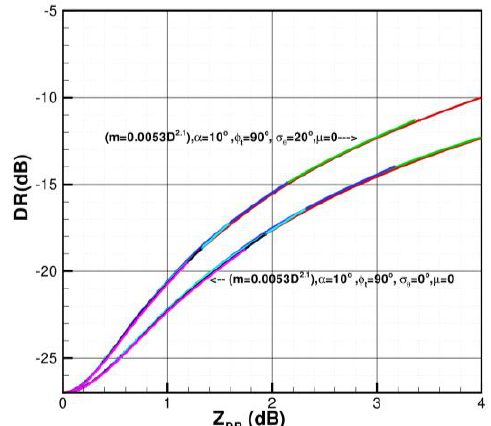
Figure 3. r -DR relations assuming D mv = 0.1 cm and di ff erent assumptions for the radar elevation angle Figure 3. r- DR relations assuming D mv = 0.1 cm and different assumptions for the radar elevation angle α , the transmission phase shift ϕ t, the standard deviation of particle wobbling σ θ , and the coe ffi cients α, the transmission phase shift φt, the standard deviation of particle wobbling σ θ , and the coefficients in particle mass-size relation. Di ff erent color segments correspond to results of modeling with di ff erent in particle mass-size relation. Different color segments correspond to results of modeling with D mv values (i.e., 0.05, 0.1, 0.2, 0.3 and 0.5 different D mv values (i.e., 0.05, 0.1, 0.2, 0.3 and 0.5 cm).